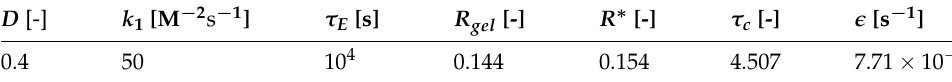
(cid:16) (cid:17) ≈ 0.3 leads to e − k E ( t ∗ − t gel ) ≈ 0.74 and t ∗ − t gel